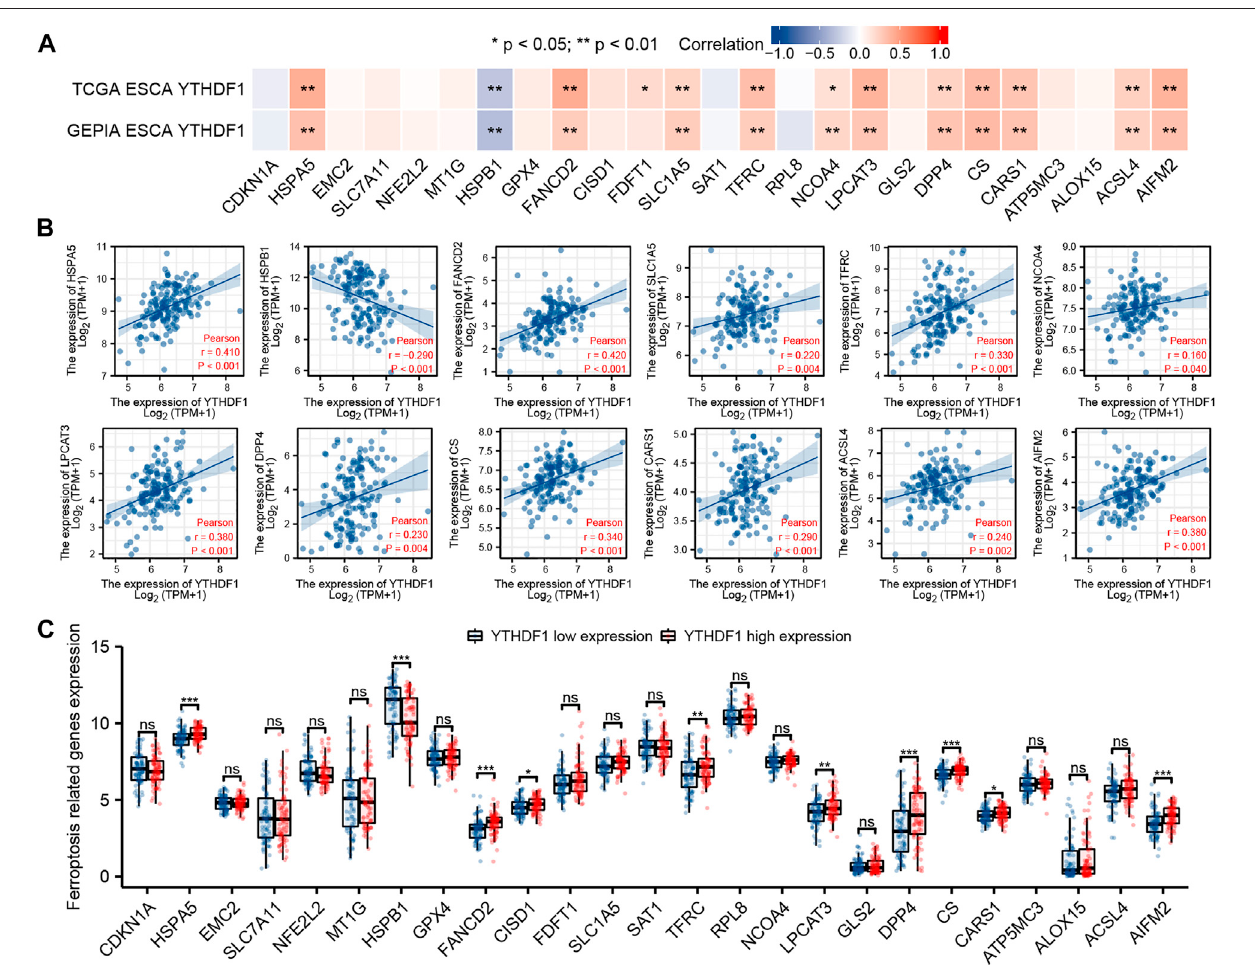
FIGURE 8 | Correlation between YTHDF1 expression and ferroptosis-related genes in esophageal carcinoma (ESCA). (A) Correlation between expression of YTHDF1and 25ferroptosis-relatedgenesinTCGA and GEPIA ESCA cohorts. (B) Scatter plotdemonstrate thecorrelation betweenYTHDF1and 12ferroptosis-related genes (HSPA5, FANCD2, SLC1A5, TFRC, NCOA4, LPCAT3, DPP4, CS, CARS1, ACSL4, AIFM2, and HSPB1) in TCGA ESCA cohort. (C) Differential expression of 25 ferroptosis-related genes between the high and low expression groups of YTHDF1 in ESCA. * p < 0.05; ** p < 0.01; *** p < 0.001; ns, no signi fi